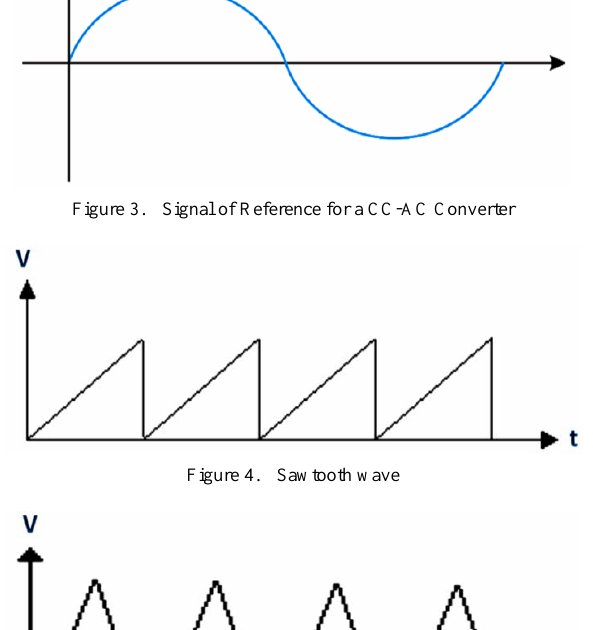
Figure 5. Triangle wave